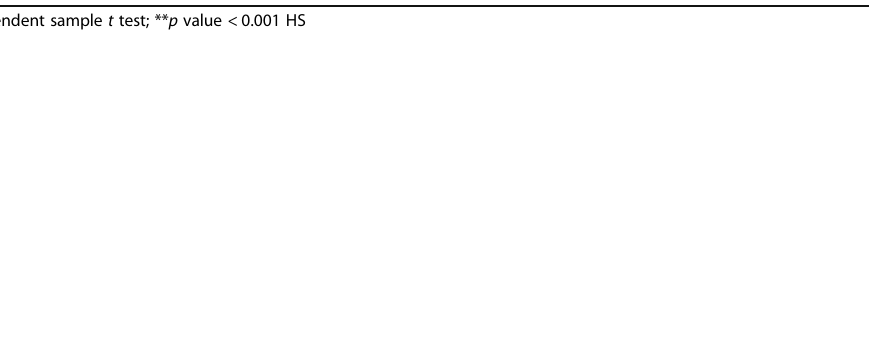
Table 5 Total dose of morphine (mg) group A compared to group B Total consumption of morphine (mg) Group A ( n =50) Group B ( n =50) t test p value Mean±SD 8.24±2.06 5.15±2.16 6.381